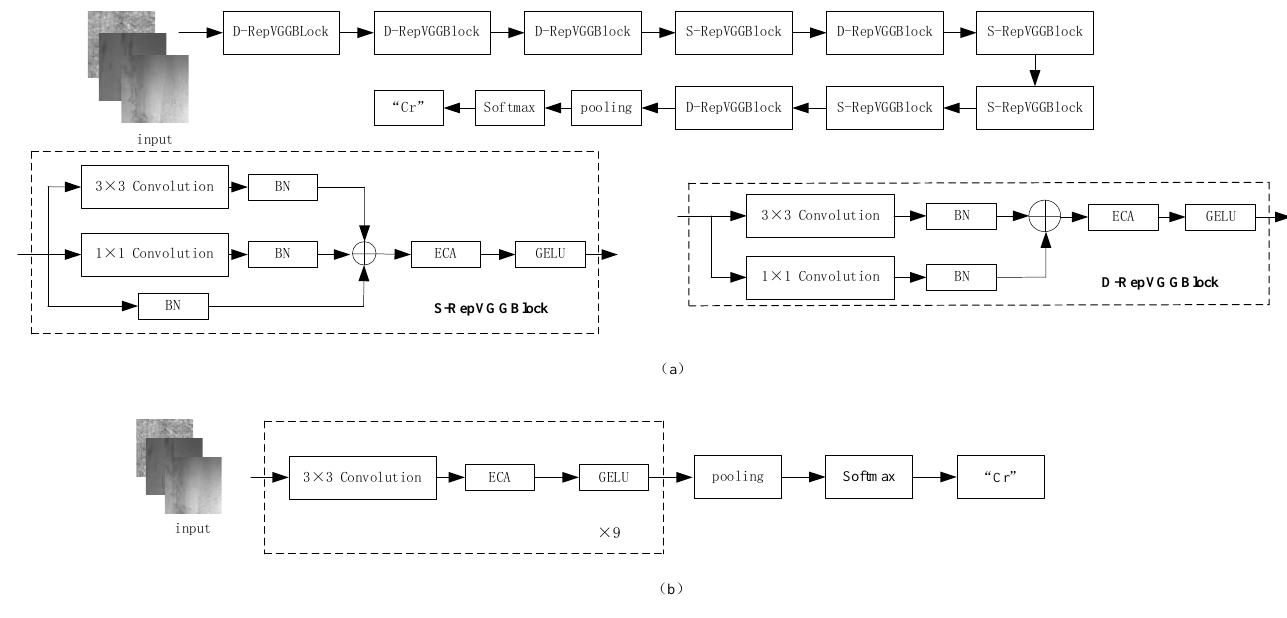
Figure 2. KD-EG-RepVGG Network. ( a ) KD-EG-RepVGG Training Network. ( b ) KD-EG-RepVGG Inference Network. Table 1. KD-EG-RepVGG Network Structure Details.